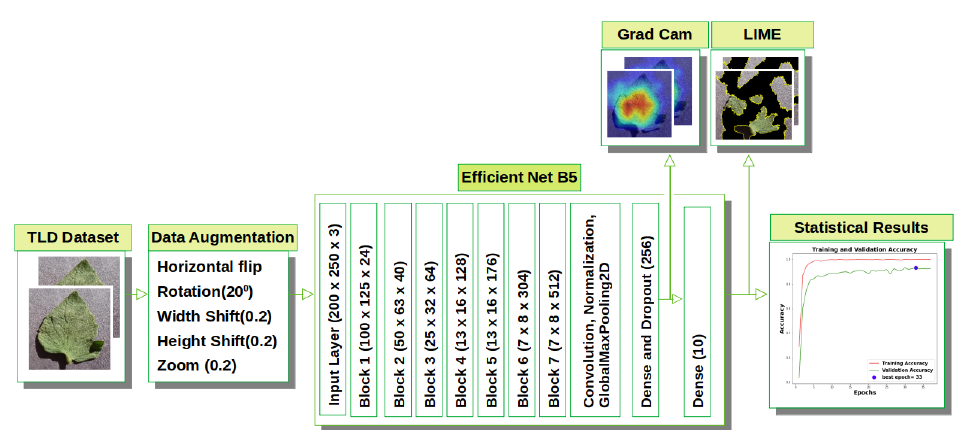
Figure 2. Proposed high level conceptual architecture of explanation − driven DL model (BotanicX-AI) for TLD